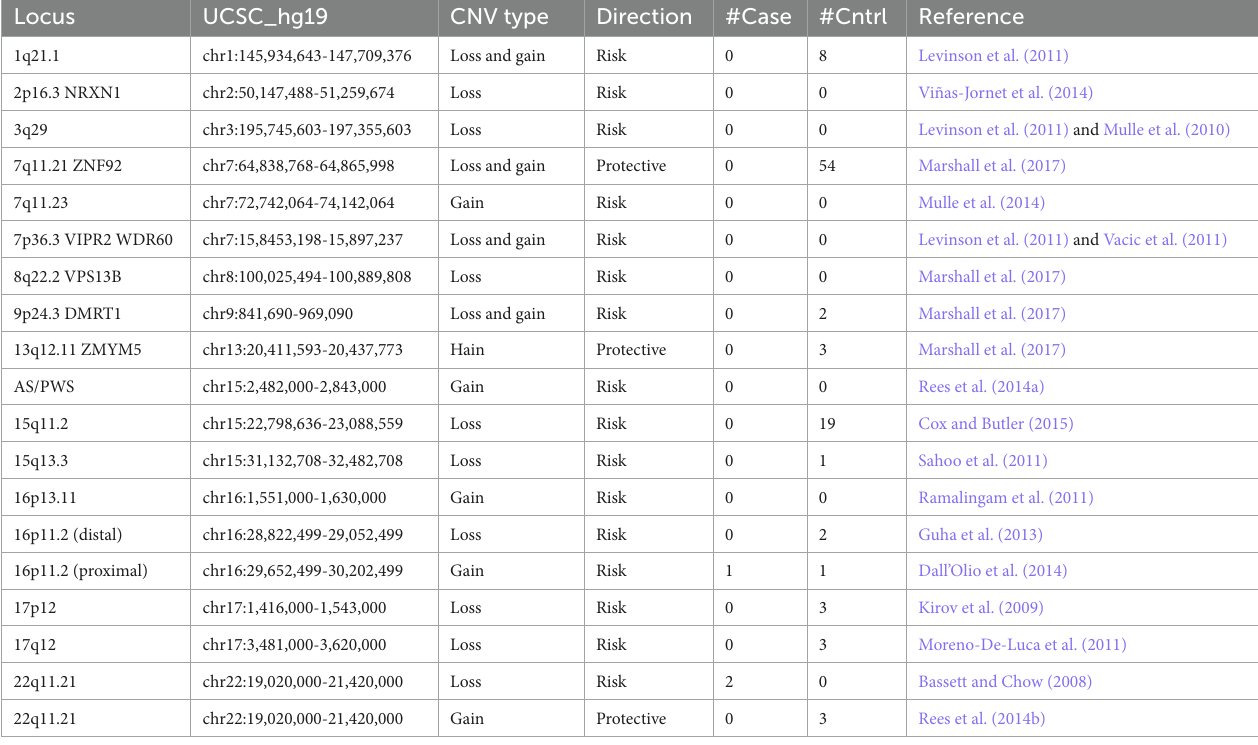
TABLE 4 Number of cases and controls with samples and events >100 kilobases in known regions. Locus